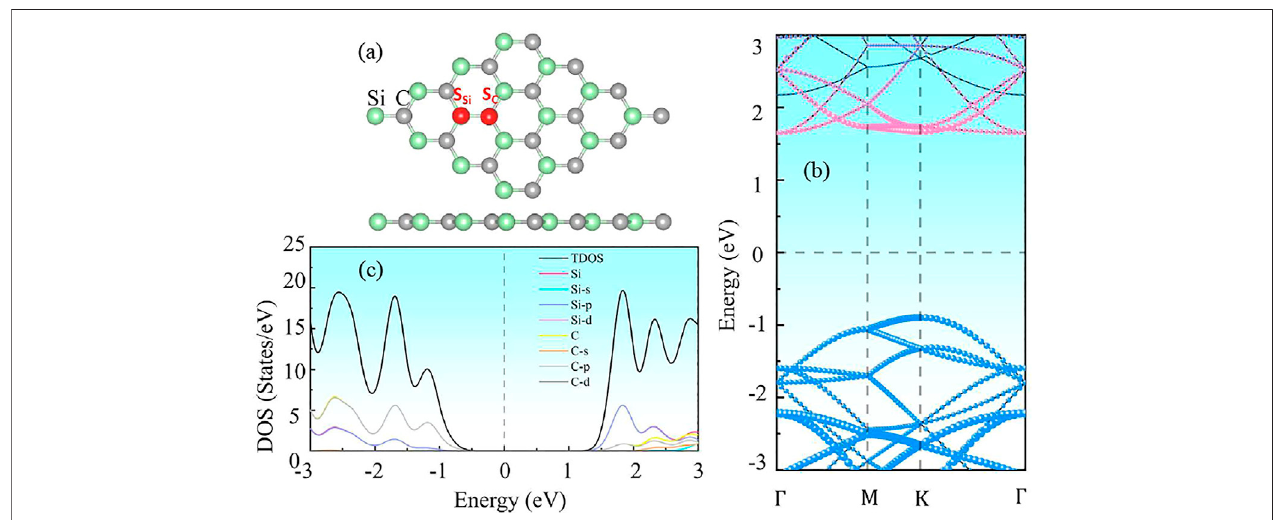
FIGURE 1 | The (A) crystal structure, (B) energy band structure, and (C) density of states of intrinsic 2D SiC.